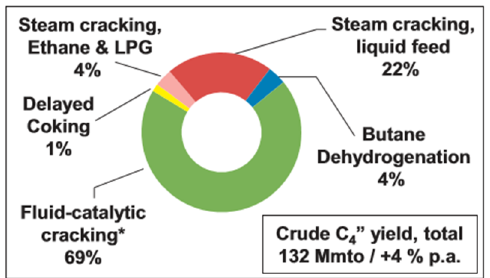
Figure 4. C 4 olefin production methods using hydrocarbon feedstocks. Reproduced from [3]. 2014, WILEY ‐ VCH Verlag GmbH &